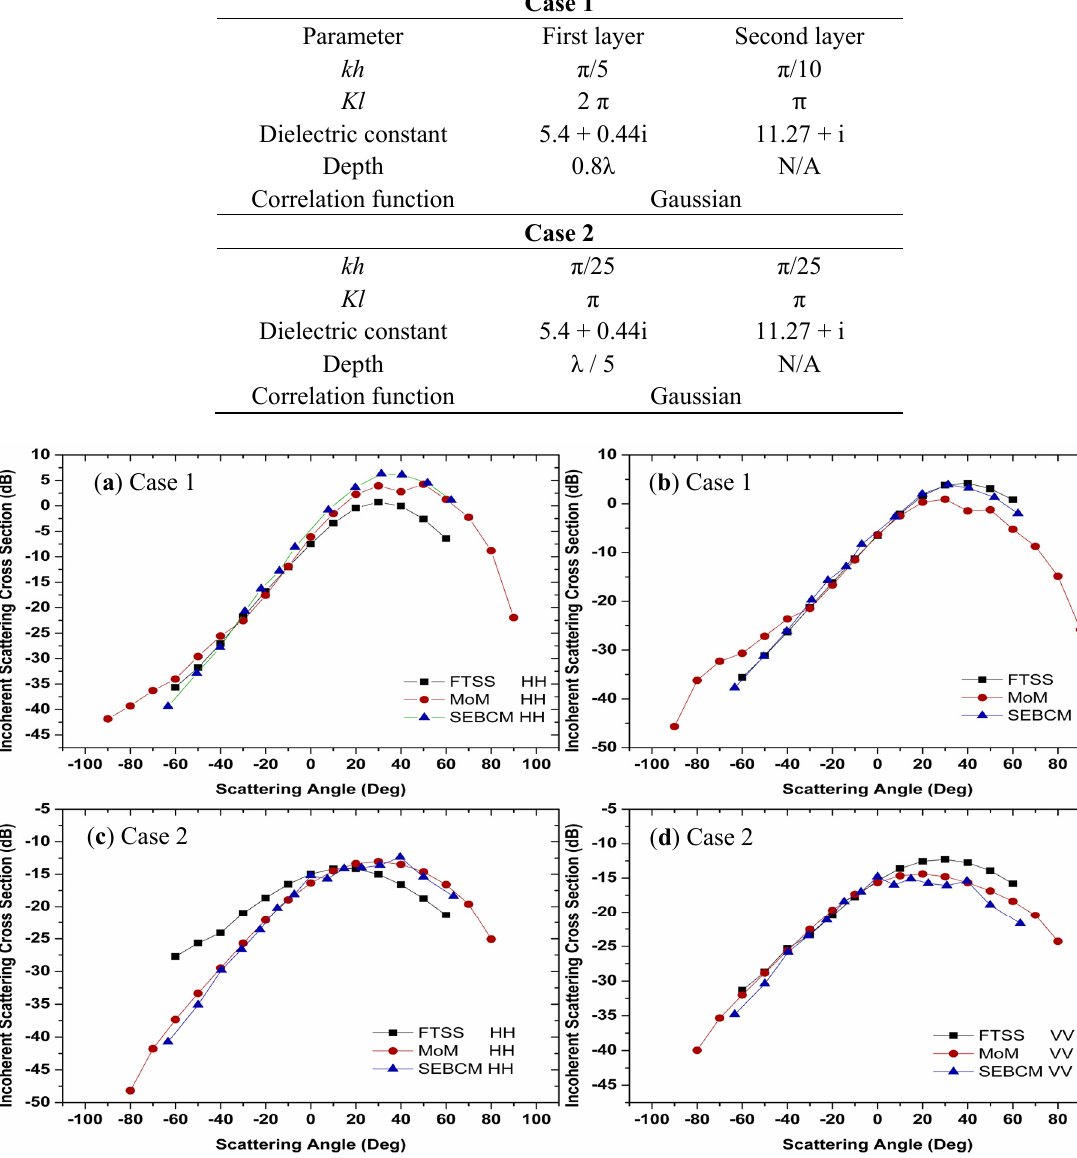
Table 2. Input parameters for model simulations; k is the free space wavenumber, λ is wavelength, h and l are the surface Root Mean Square (RMS) height and Correlation length, respectively. Sensing incident angle is fixed at 40°.